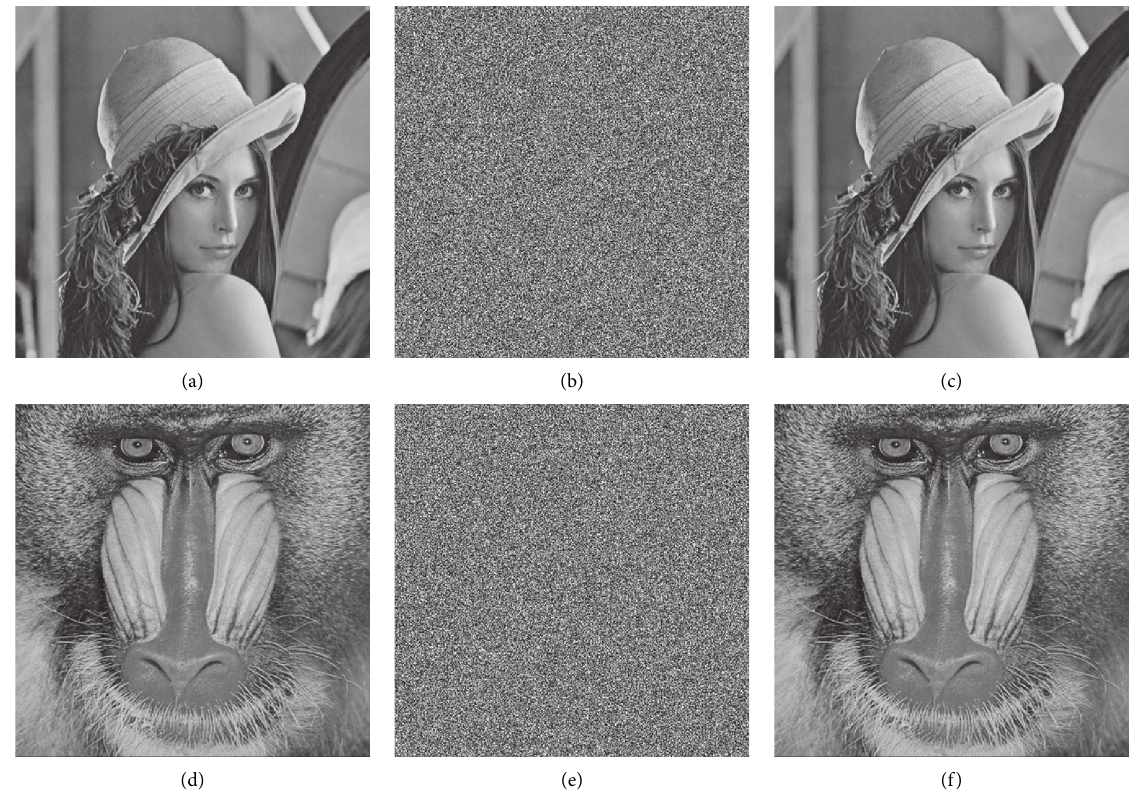
Figure 5: The simulation results of encryption and decryption: (a, d) plain images; (b, e) cipher images; (c, f) decrypted